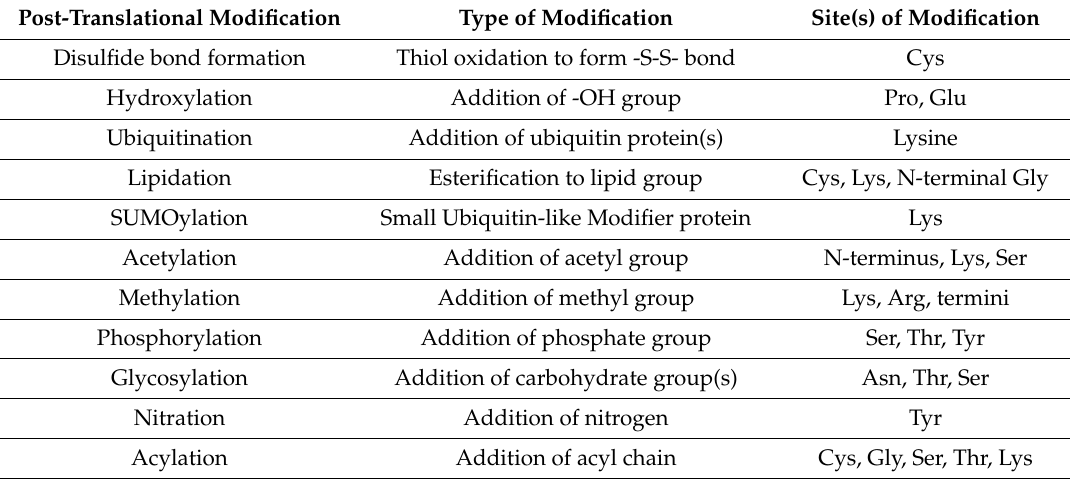
Table 1. Common post-translational modifications of